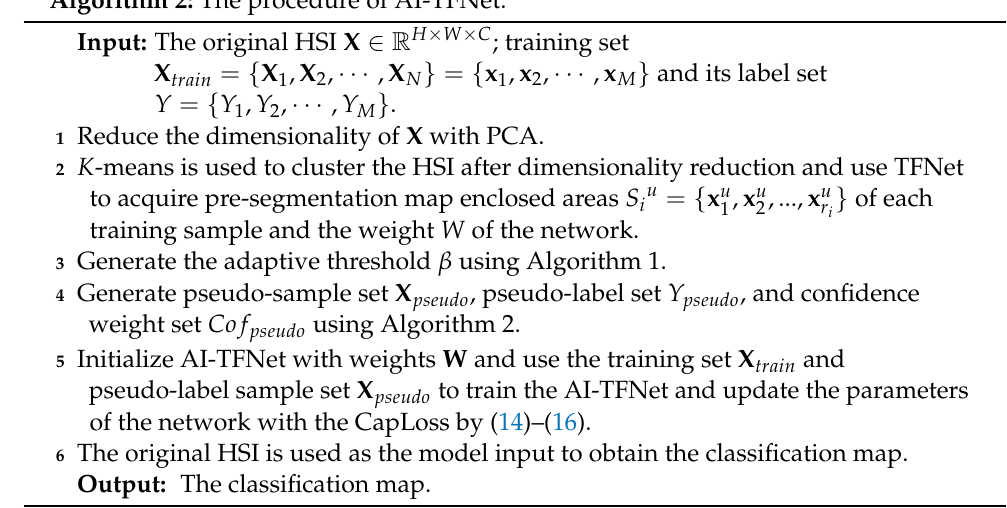
Algorithm 2: The procedure of AI-TFNet.